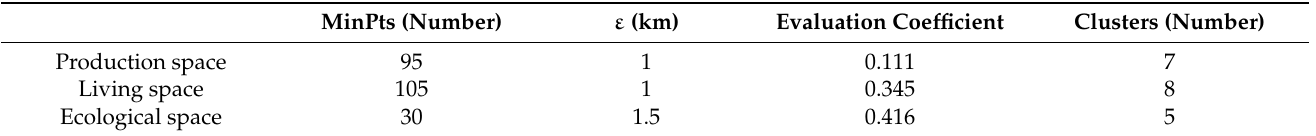
Table 2. The “production–living–ecological” spatial clustering parameters. MinPts (Number) ε (km) Evaluation Coefficient Clusters (Number) Production space 95 1 0.111 7 Living space 105 1 0.345 8 Ecological space 30 1.5 0.416